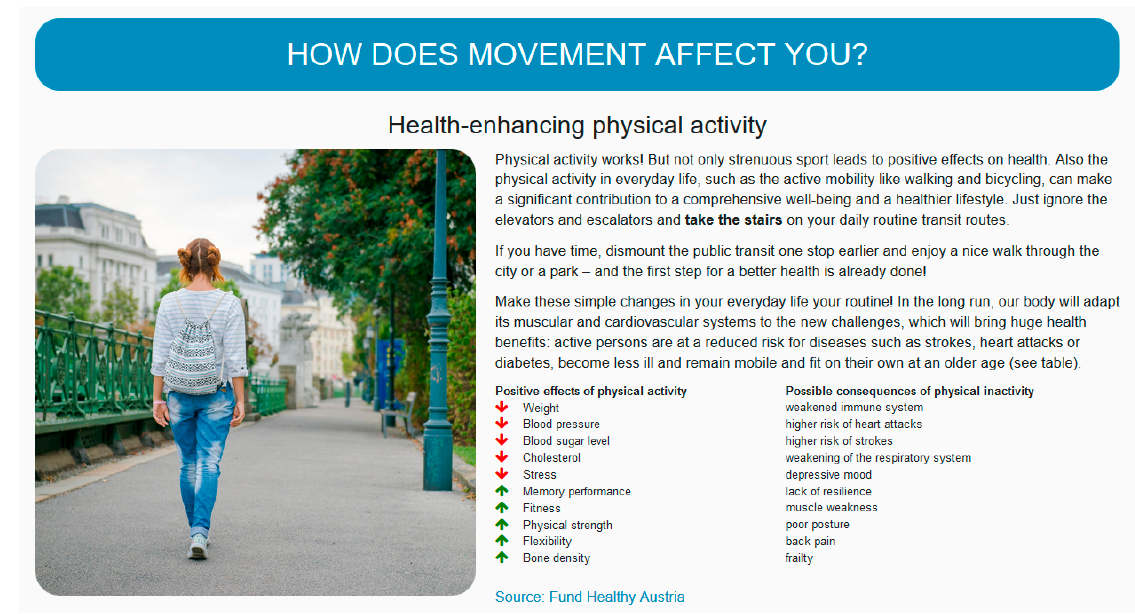
Figure 2. World Health Organization (2010) physical activity recommendations. Figure by Fonds Gesundes Österreich (2018).